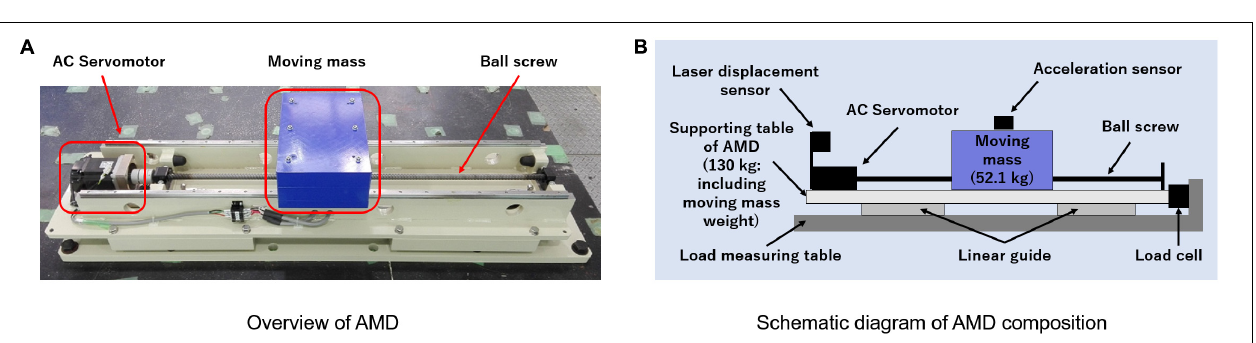
FIGURE 2 | Configuration outlook of the test device of AMD. (A) Overview of AMD. (B) Schematic diagram of AMD